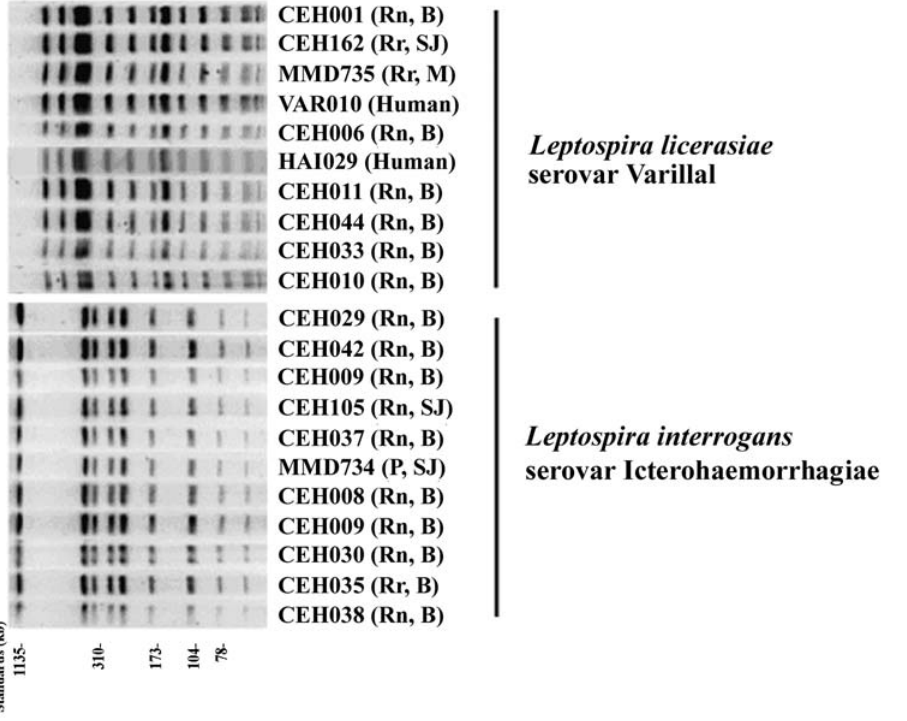
Figure 1. Pulsed field gel electrophoresis analysis of leptospiral isolates obtained from rats and humans in the region of Iquitos, Peru. Indicated in parentheses is animal source of leptospiral isolate followed by location of trapping (see Methods). Rn, Rattus norvegicus; Rr, Rattus rattus . B, Belen; SJ, San Juan; M, Moralillo.